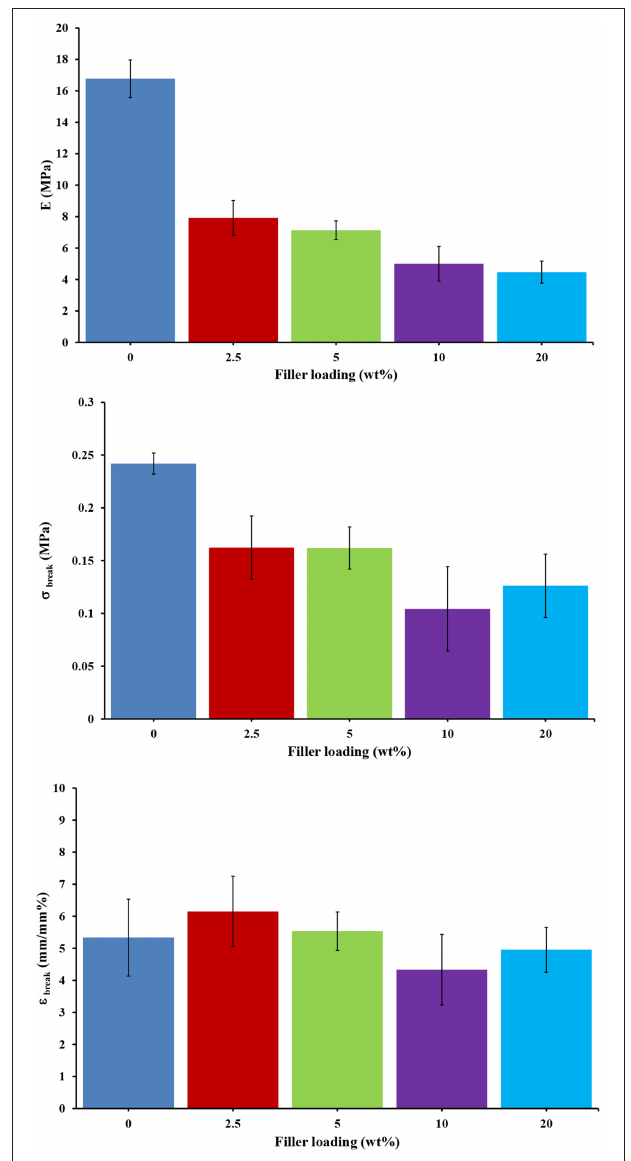
FIGURE 5 | Mechanical parameters for unfilled TPs film and